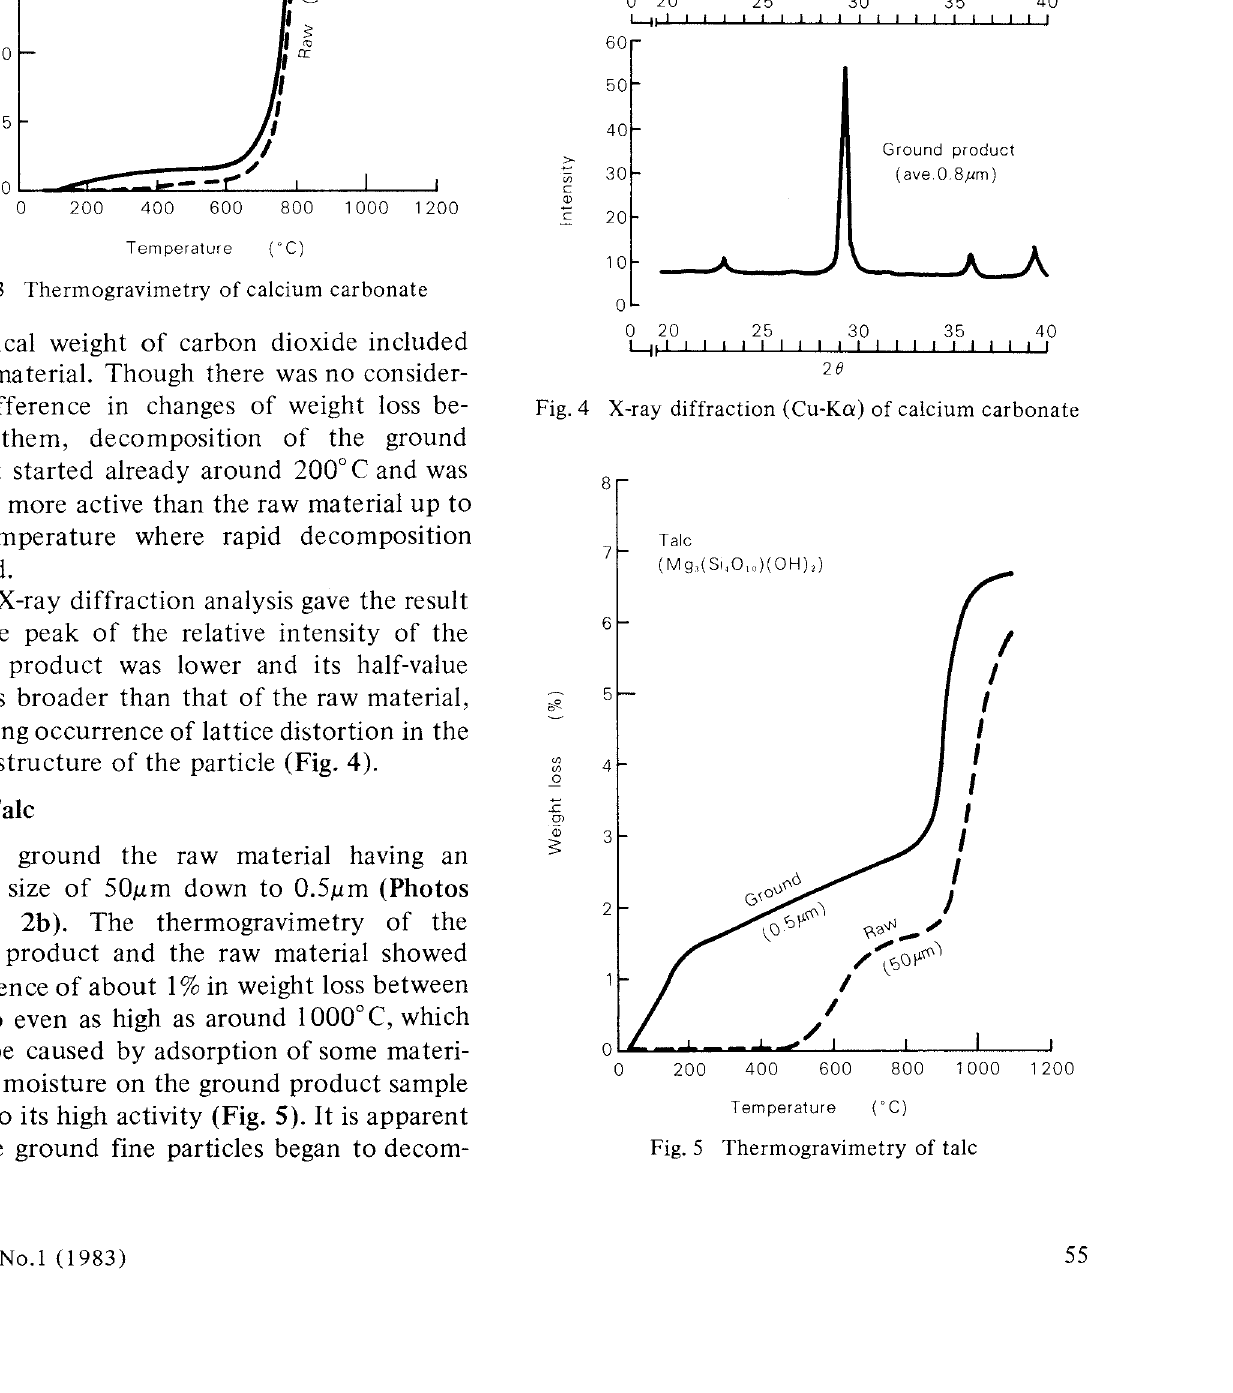
Fig. 5 Thermogravimetry of